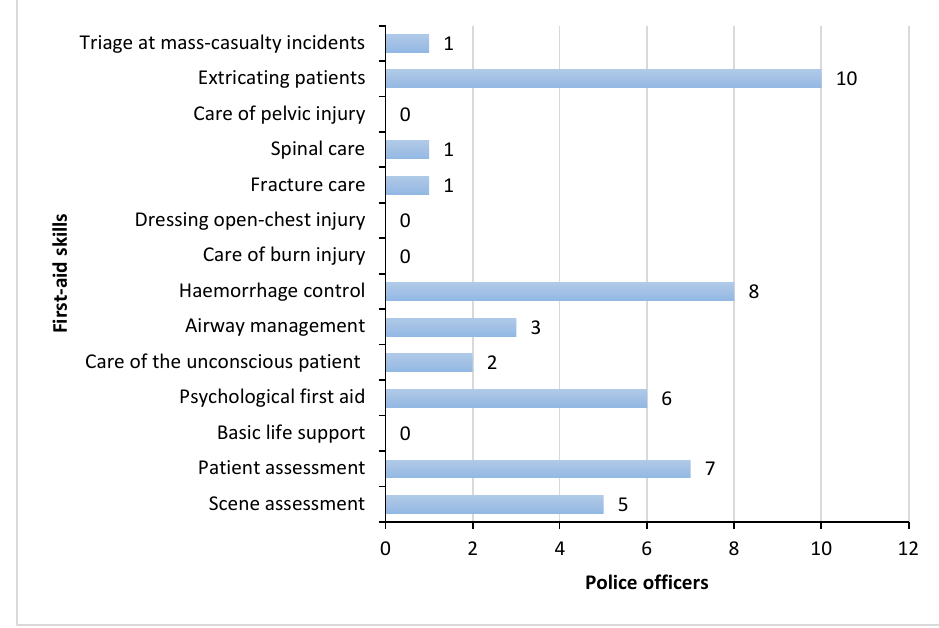
Figure 2. First Aid Skills Applied in Practice.